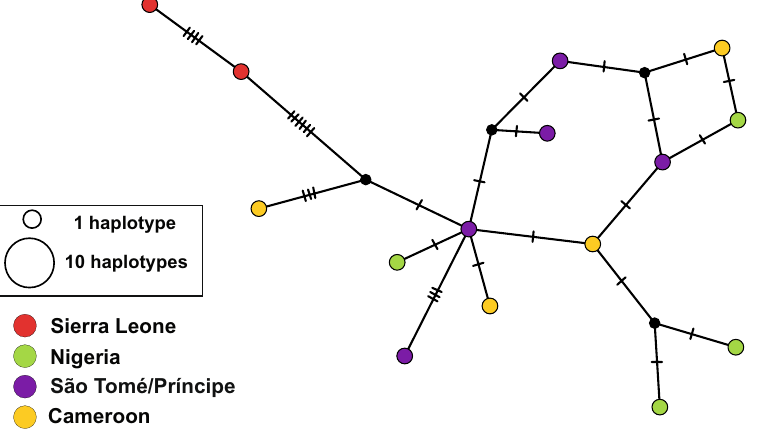
Figure 4. Median-Joining network of the East Atlantic clade of Petrolisthes armatus , based on concatenated haplotypes of 16S and two regions of COI. Notation as in Fig. 3.